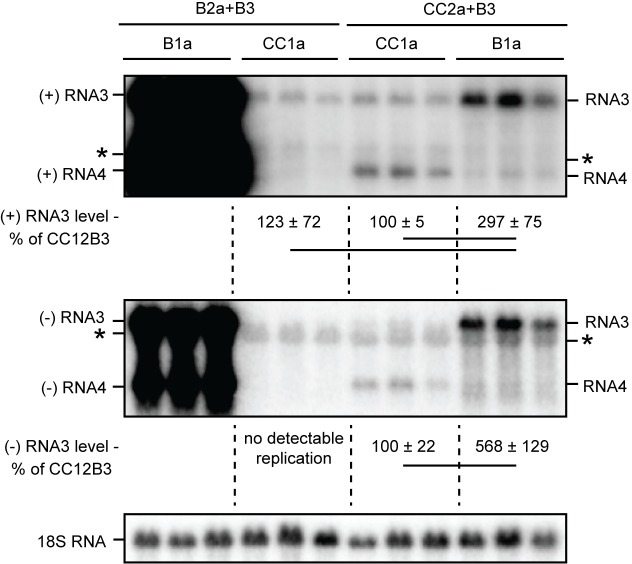
CCMV 2a polymerase is competent for negative-strand RNA synthesis in yeast.Northern blotting was used to detect viral RNA from yeast expressing BMV RNA3 with different combinations of BMV or CCMV 1a and 2apol as indicated. 18S RNA is shown as a loading control. Bands other than (+)RNA3 present in the absence of RNA replication are marked with a an asterisk. The average and standard deviation of each triplicate shown is presented beneath the blots. A line connecting two numbers indicates a statistically significant difference (p<0.05).